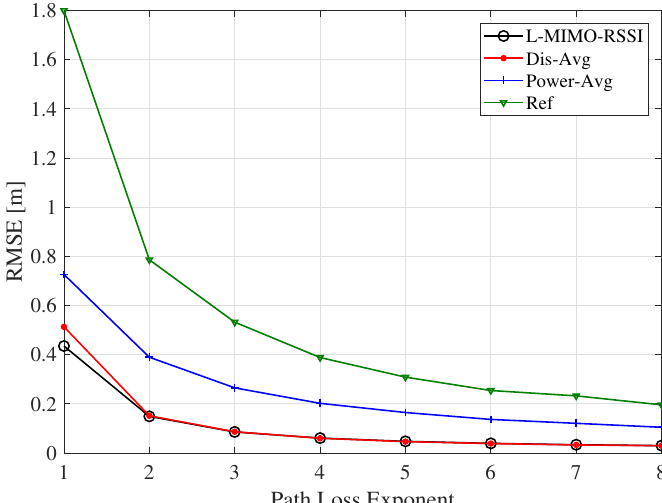
Figure 16. The RMSE for the proposed algorithms for different path loss exponent values. M = 50, N = 8, σ =